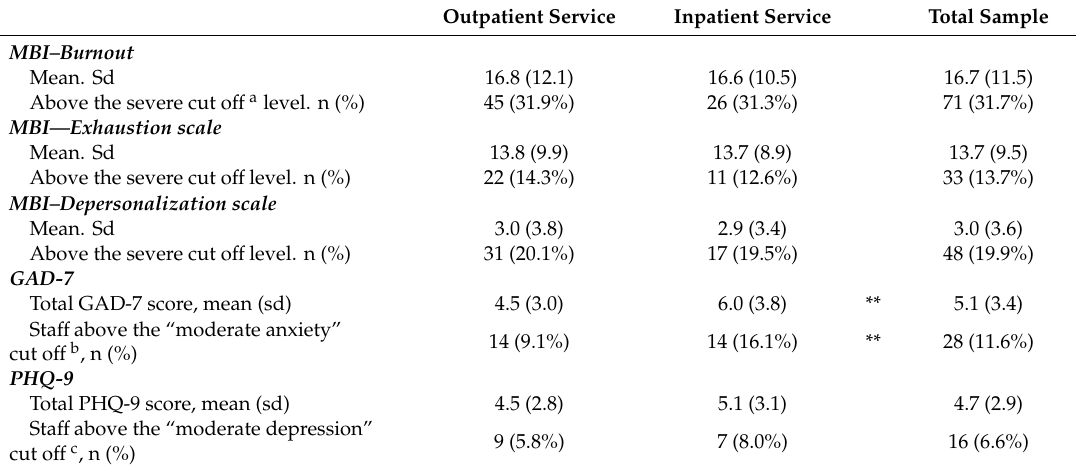
Table 3. Psychological distress of mental health workers.